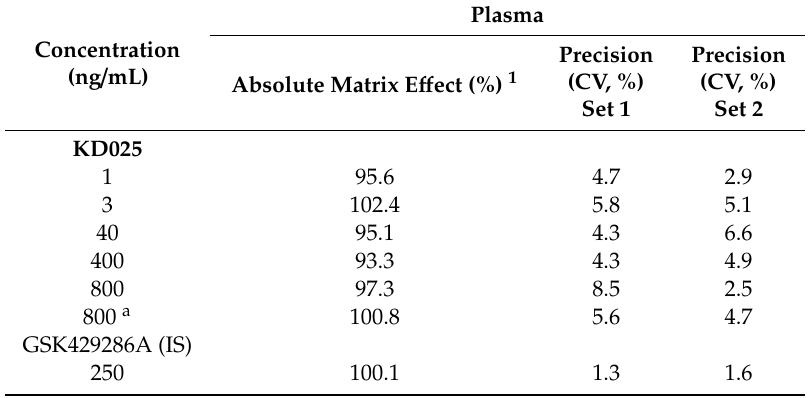
Table 2. Matrix e ff ect and precision (CV, %) for KD025 and GSK429286A (IS) in rat plasma (n = 3).